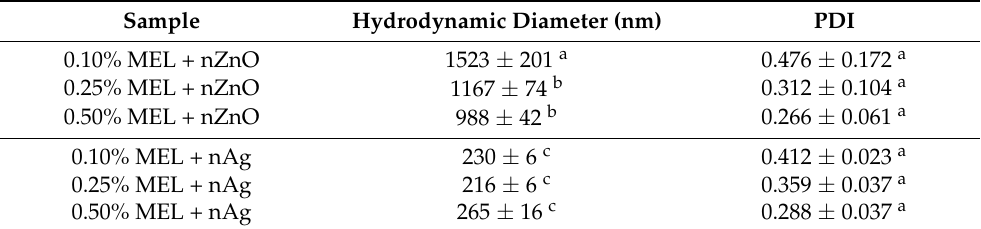
Values are means ± standard deviation. Means with different letters (a–c) are significantly different at p < 0.05 (compared to other variants within